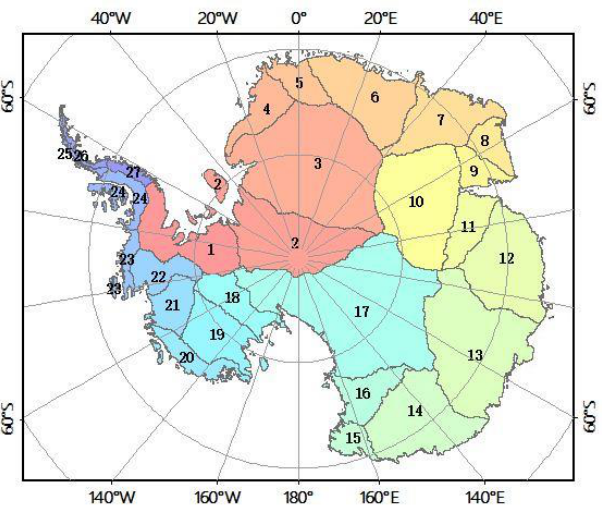
Figure 3. The drainage basins of the Antarctica Ice Sheet (Zwally et al., 2015). The Antarctic ice sheet is divided into 27 basins. The East Antarctic and West Antarctic ice sheets (EAIS and WAIS, respectively) are roughly separated along the Trans- Antarctic Mountains. The EAIS is divided into 16 basins (2-17), the WAIS is divided into 7 basins (1, 18-23) and the Antarctic Peninsula is divided into 4 basin basins